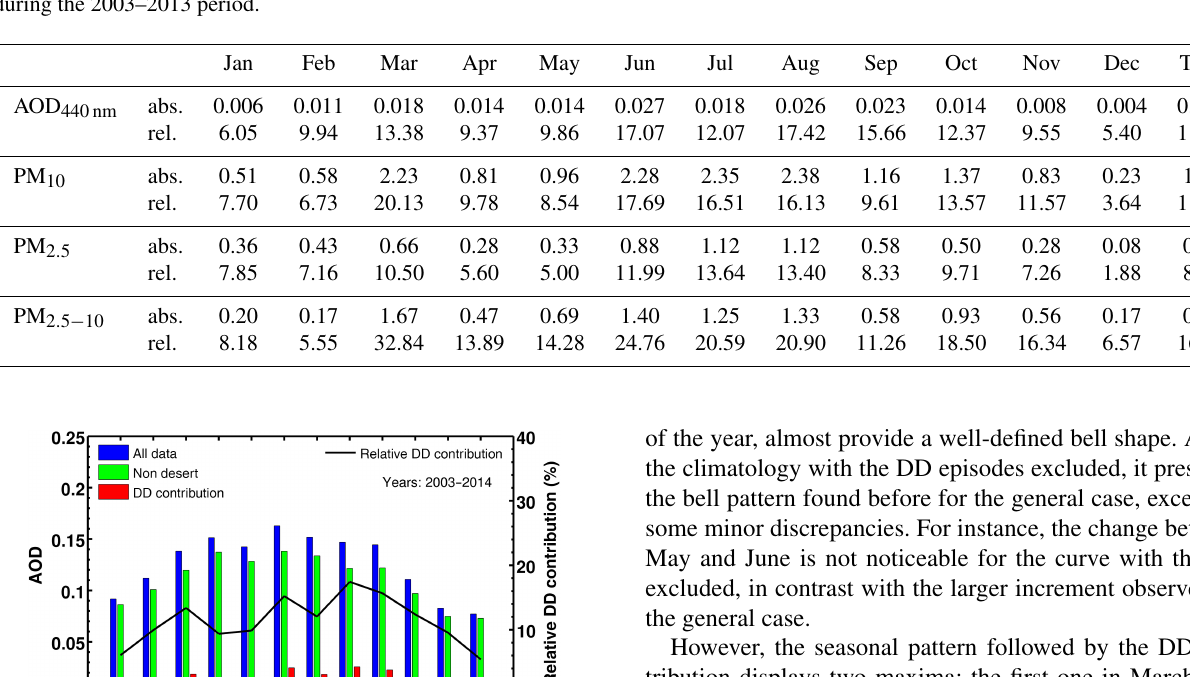
Table 4. Monthly mean contribution of DD to total AOD and PM x , in absolute (“abs.”, AOD units and µgm − 3 ) and relative (“rel.”, %) values during the 2003–2013 period.